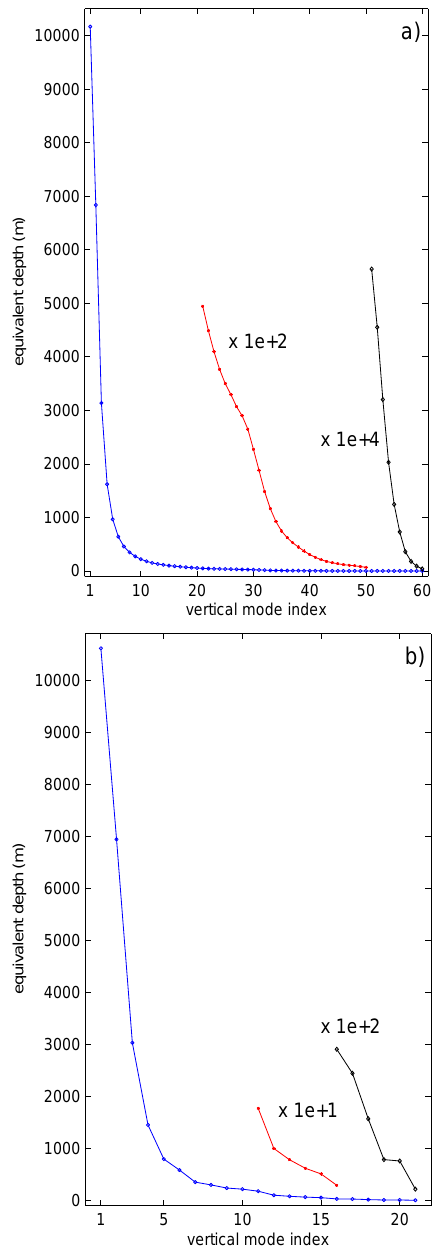
Figure 3. Values of the equivalent depths D obtained as solution of the vertical structure equation for ERA Interim modelling sys- tem: (a) 60 model levels and (b) the 21 model levels closest to the standard 21 pressure levels. A part of equivalent depths in (a) is also shown multiplied by factor 100 (modes 21–50) and by factor 10000 (modes 51 to 60). A part of equivalent depths in (b) is similarly mul- tiplied by factor 10 (modes 11–16) and by factor 100 (modes 16 to